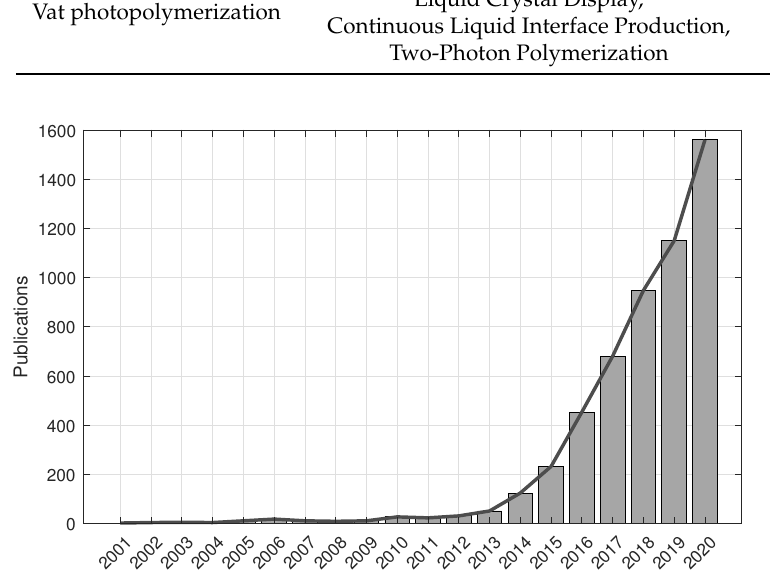
Figure 1. Publication trends. The bar graph shows the total number of publications per year from 2001 to 2020 (in Google Scholar: https://scholar.google.com/, accessed on 26 July 2021) with keywords: “3D printing”, “microfluidic” and “additive manufacturing”.